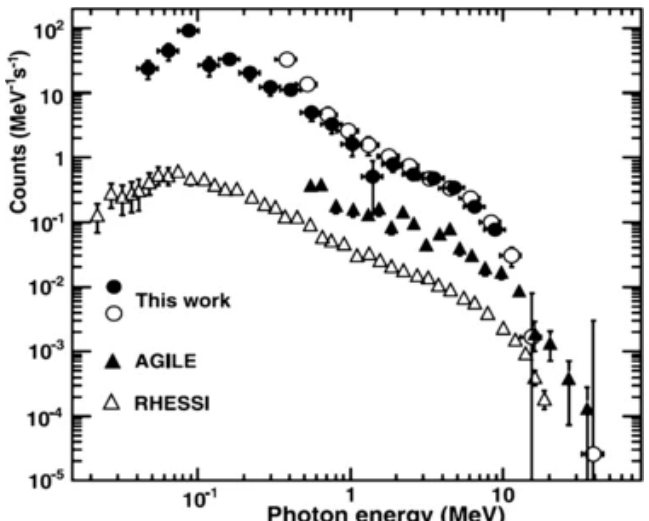
Figure 13. Summed spectra of three glows observed by NaI (solid circles) and CsI (open circles) detectors. For comparison, the spectra of many summed TGFs from RHESSI and AGILE are shown. None of the spectra are corrected for the various responses of the instruments, but the similarity is obvious. Adapted from